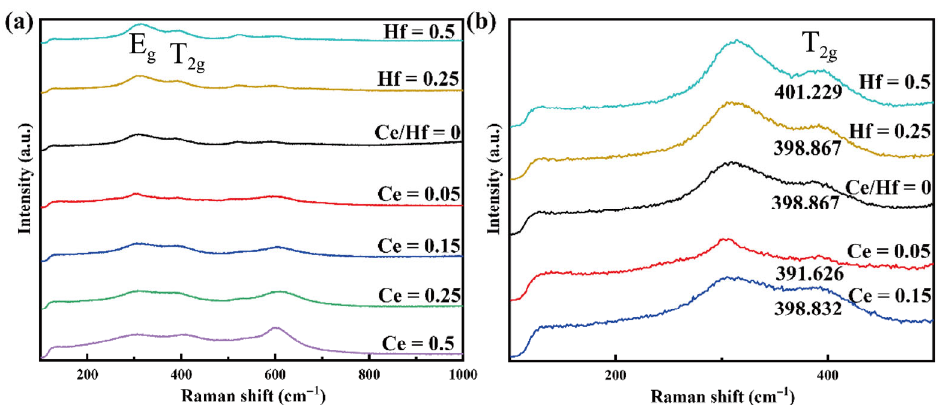
Fig. 2 Raman analysis of A 2 B 2 O 7 high-entropy ceramics: (a) Raman spectra of the prepared high-entropy ceramics; (b) T 2g model of ceramics containing pyrochlore